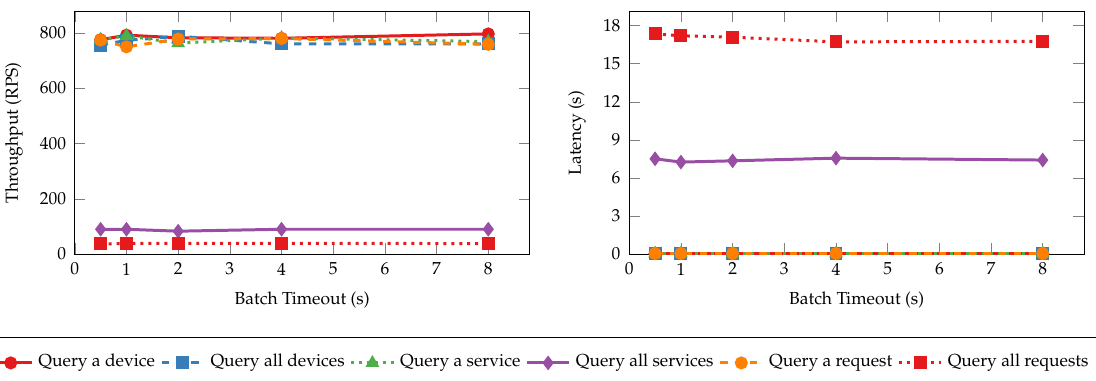
Figure 15. Throughput and latency of read operations for varying batch timeouts. Figures 17 and 18 depict the average system resource utilization of orderer and peer nodes for the tested batch timeouts. Similar to the previous experiments, read operations exhibit consistent resource usage given different batch timeouts. Transaction operations, on the other hand, consume more orderer and peer CPU for small batch timeouts. The CPU usage decreases in the same fashion as the throughput when the timeout